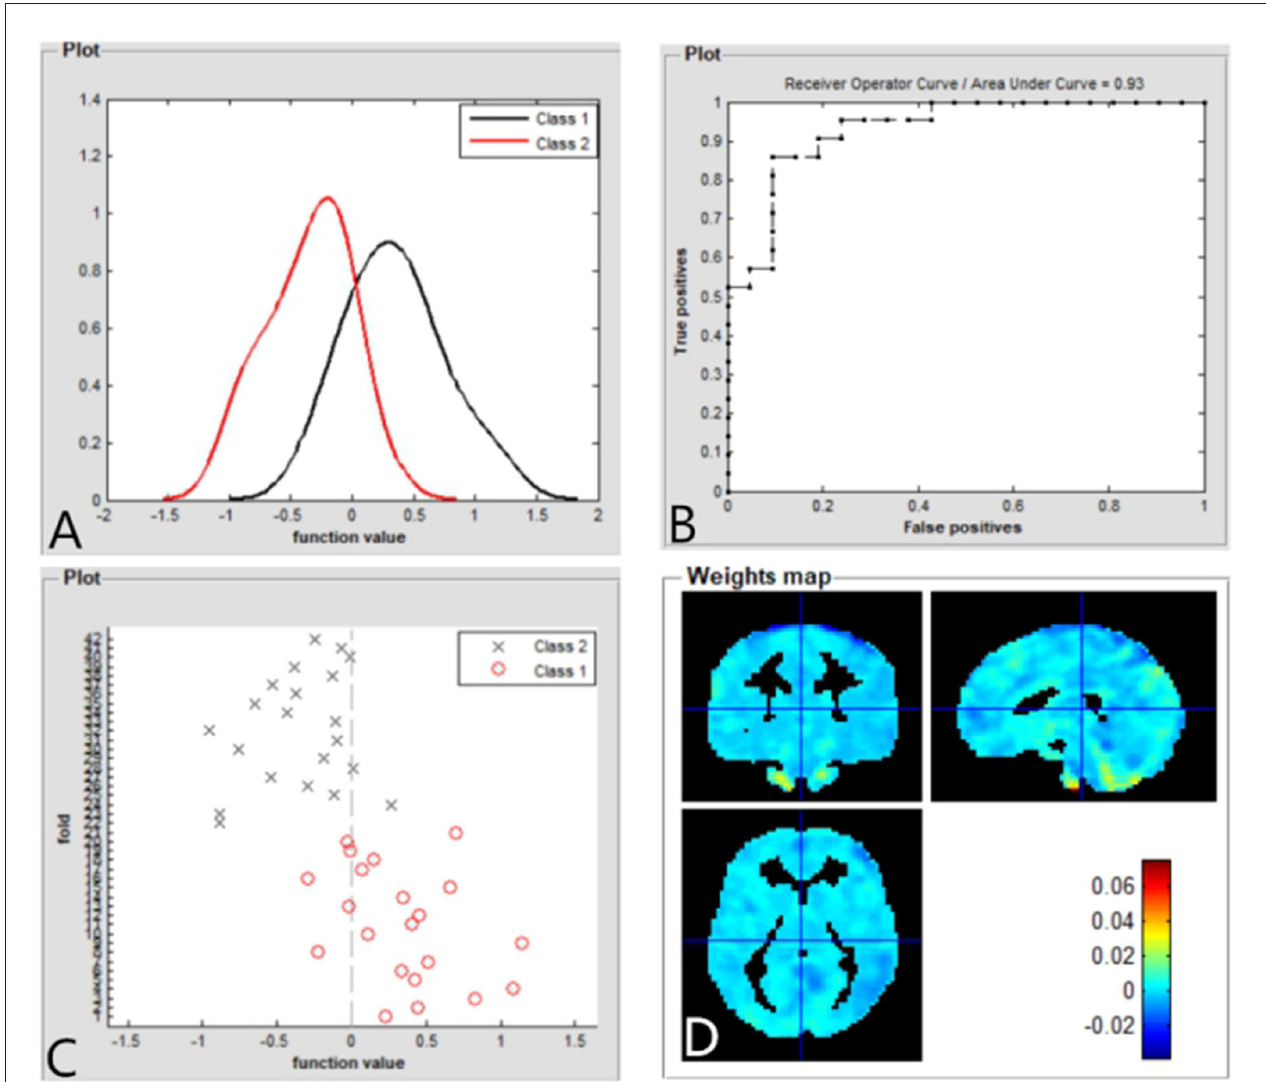
FIGURE 4 | Based on ALFF values, distribution of function values of the two groups (class 1: patient group; class 2: HC group) (A) ; the ROC curve of the classifier, and the AUC was 0.93 (B) ; function values of the two groups (class 1: CE group; class 2: HC group) (C) ; and weight maps for SVM models (D) . ALFF, amplitude of low-frequency fluctuation; ROC, receiver operator characteristic; AUC, areas under the curve; CE, comitant exotropia; HC, healthy control; SVM, support vector machine.